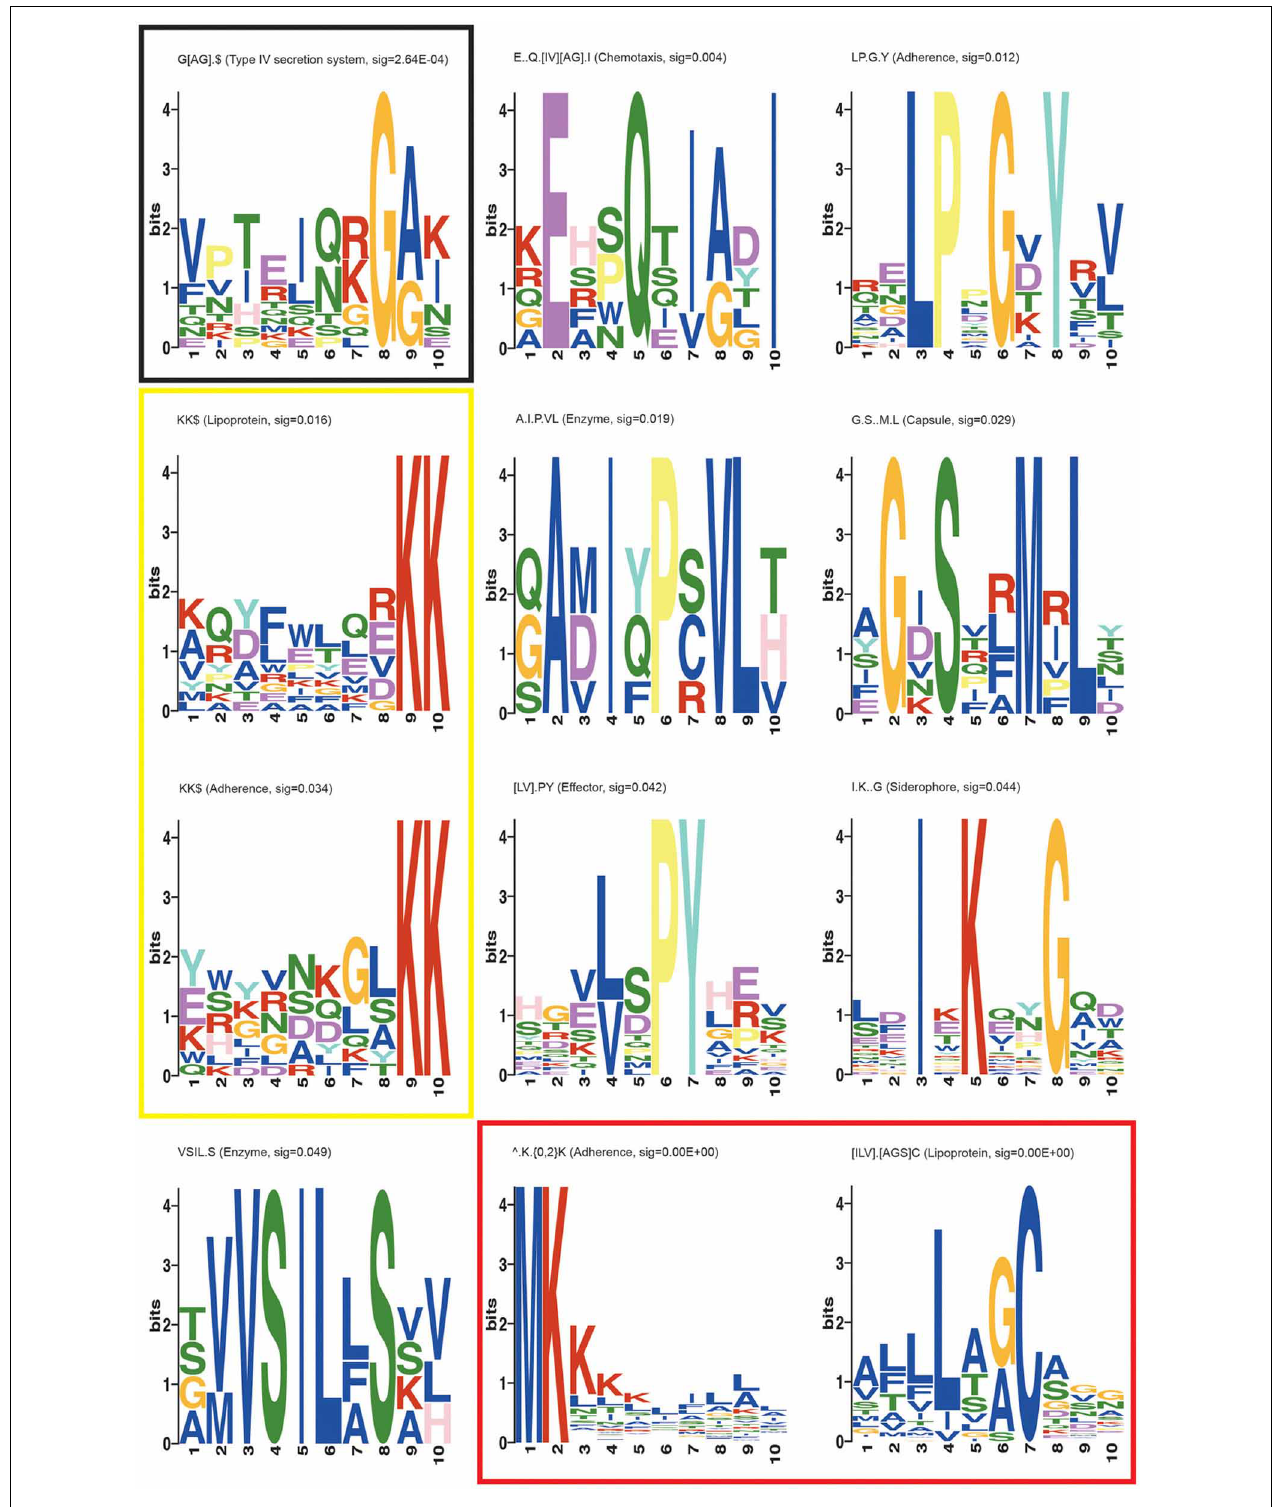
FIGURE 1 | MEME suite motif logos of the novel and known motifs returned in the SLiMFinder analysis. Each position in the motif is represented as a stack of letters. The total height of the stack is the “information content” of that position in the motif in bits. The height of the individual letters in a stack is the probability